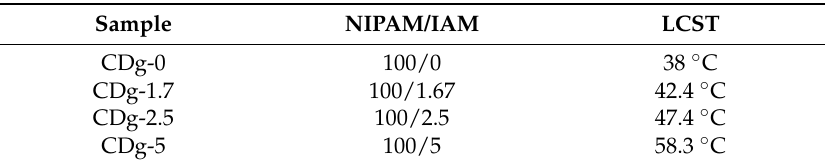
Table 3. NIPAM/IAM ratios and LCSTs of hydrogels.